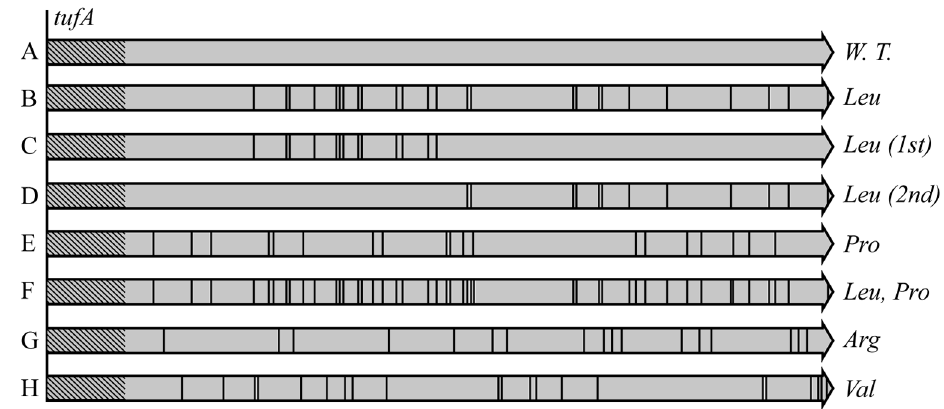
Fig 1. Overview of the design of synonymous tuf alleles. The first forty codons in tuf were left unchanged to reduce the possible impact of N-terminal codon usage bias (hatched region). Black bars represent codons that have been changed to synonymous codons. ( A ) Wild-type tufA gene. ( B ) Leucine codons (N = 25) were changed to UUA, UUG, CUU, CUC or CUA, respectively. ( C ) The leucine codons in the first half of the tuf gene (N = 13) were changed to UUA, CUC or CUA, respectively. ( D ) The leucine codons in the second half of the tuf gene (N = 12) were changed to UUA, CUC or CUA, respectively. ( E ) Proline codons (N = 19) were changed to CCU, CCC or CCA. ( F ) Both leucine and proline codons (N = 44) were changed: in one tuf allele all leucine codons were changed to UUG and all proline codons to CCU; in the other tuf allele all leucine codons were changed to UUA and all proline codons to CCA. ( G ) All arginine CGU codons (N = 17) were changed to CGG. ( H ) All valine GUU codons (N = 21) were changed to